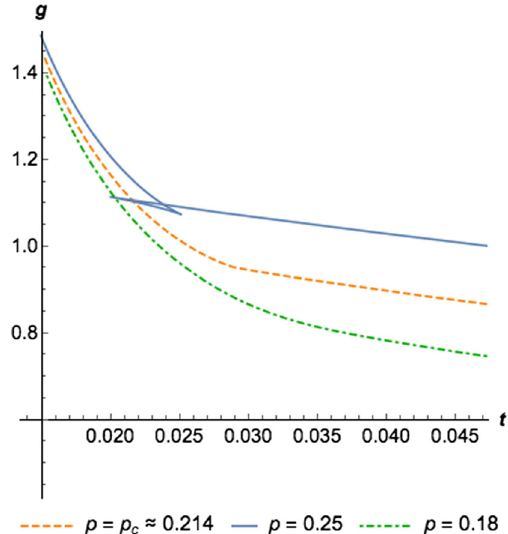
Fig. 2 g − t diagram for the radiation case ω = 1 / 3